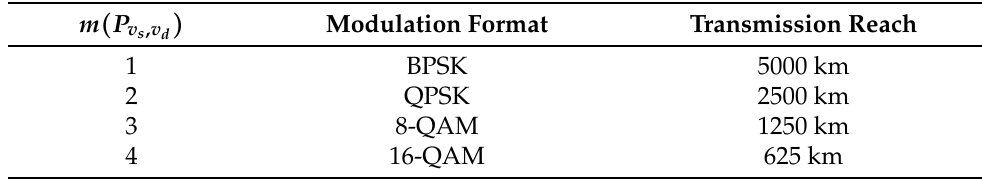
Table 1. Transmission reach for different modulation formats